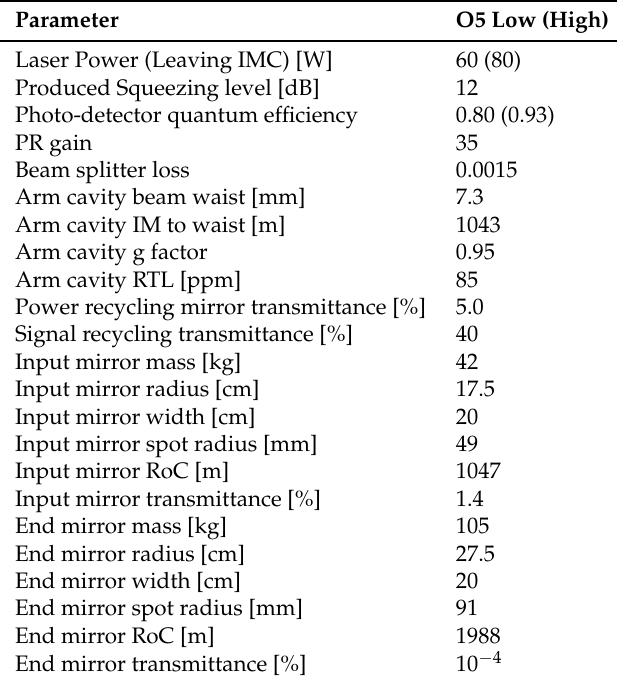
Table 1. Interferometer parameters for phase II of AdV+. The final parameter values and sensitivity curve will depend on photodetector quantum efficiency performance, achievable laser power, and mechanical losses of new coatings